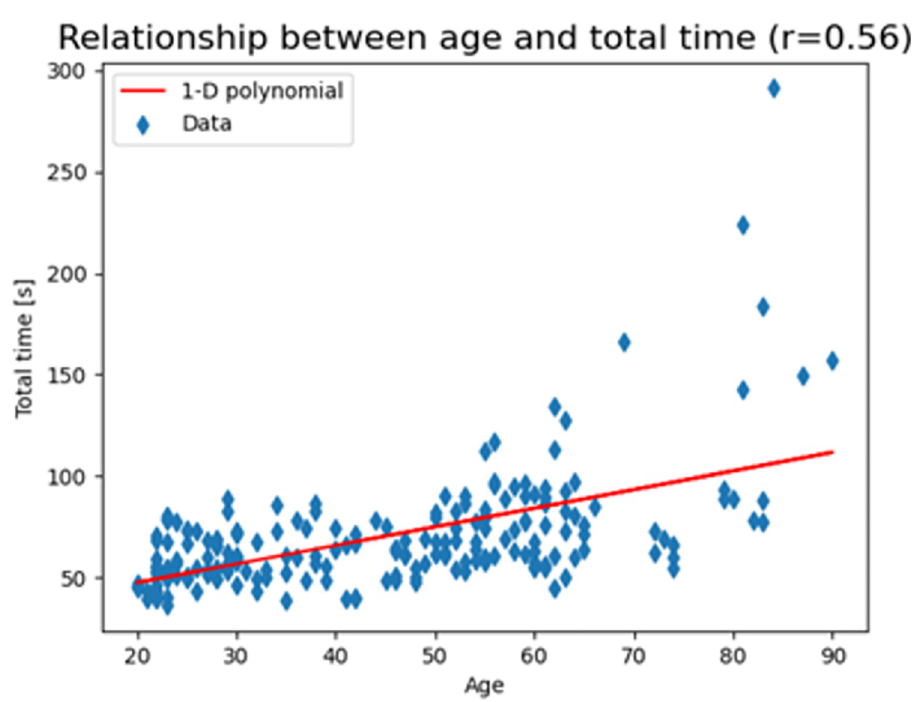
Fig 8. The scatter plot of the results with a 1-D polynomial trend line that clearly shows how total time increases with increasing age in healthy controls.